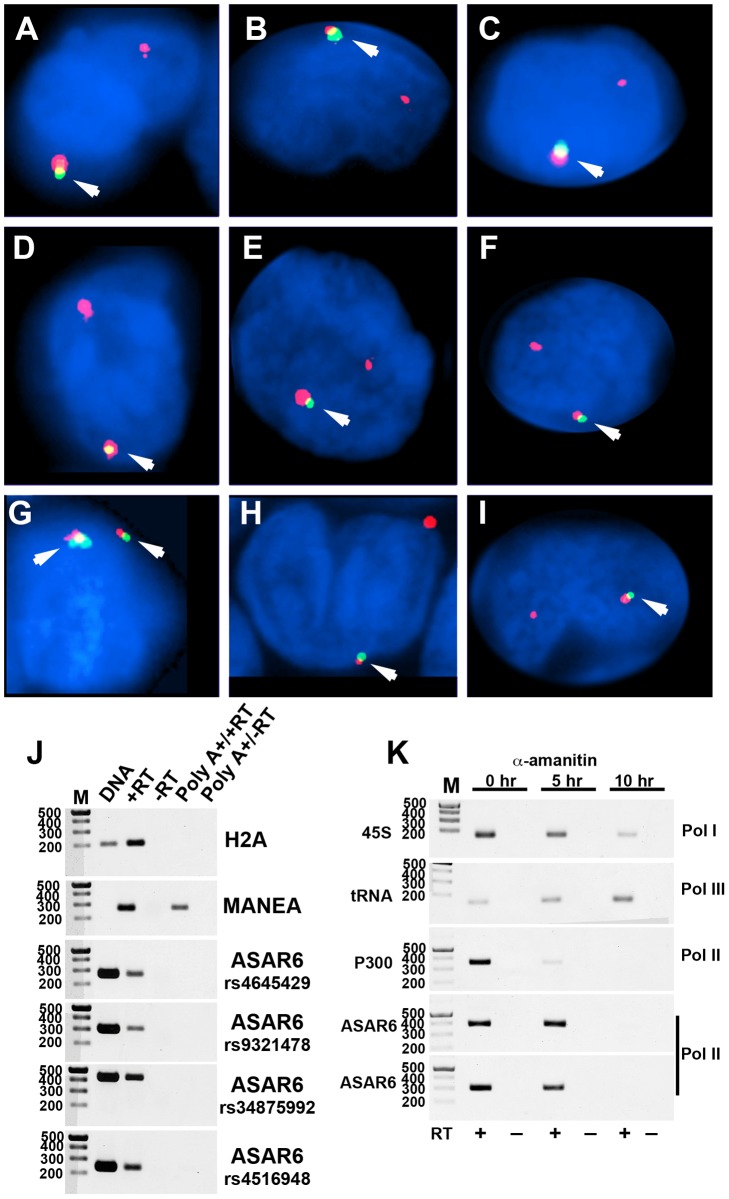
Mono-allelic expression of ASAR6 in human PBLs.A–I). RNA-DNA FISH for expression of ASAR6. PBLs were subjected to RNA FISH (green) using a Fosmid (G248P86031A6) probe for ASAR6. Slides were subsequently re-fixed and processed for DNA FISH (red) using BAC RP11-959I6, located distal to FUT9 (BAC#4 in Figure 1H). In regions of the slide where the FISH worked well, the RNA FISH probe detected a positive signal in >80% of the cells. DNA was stained with DAPI. Arrows mark the location of the RNA signals. Two sites of RNA hybridization were detected in <5% of cells (see Figure S4 for each probe in separate images). Panel G shows an example of bi-allelic expression of ASAR6. J) ASAR6 RNA is not polyadenlylated. Total RNA extracted from P175 cells was subjected to two rounds of Poly A selection followed by reverse transcriptase reactions (RT) in the presence (+) or absence (−) of reverse transcriptase followed by semi-quantitative PCR using primers to histone H2A, MANEA, or ASAR6. Genomic DNA was used as positive control. The primers used to detect MANEA cDNA span an intron and therefore do not result in a product in the genomic DNA lane. Four independent PCRs, from four different regions of ASAR6 (each spanning a different SNP; rs4645429, rs9321478, rs34875992, rs4516948) were used to detect ASAR6 RNA. The sizes of the DNA ladder (M) are indicated in base pairs. K) ASAR6 is transcribed by RNA Polymerase II. P175 cells were exposed to 20 ug/mL of α-amanitin for 0, 5, and 10 hours. Total RNA was subjected to reverse transcriptase reactions (RT) in the presence (+) or absence (−) of reverse transcriptase followed by semi-quantitative PCR using primers to 45S RNA, a tRNA, P300 and ASAR6. The sizes of the DNA ladder (M) are indicated in base pairs. Two independent PCRs, from two different regions of ASAR6 (associated with SNPs rs34875992 [top] and rs9321478 [bottom]) were used to detect ASAR6 RNA.